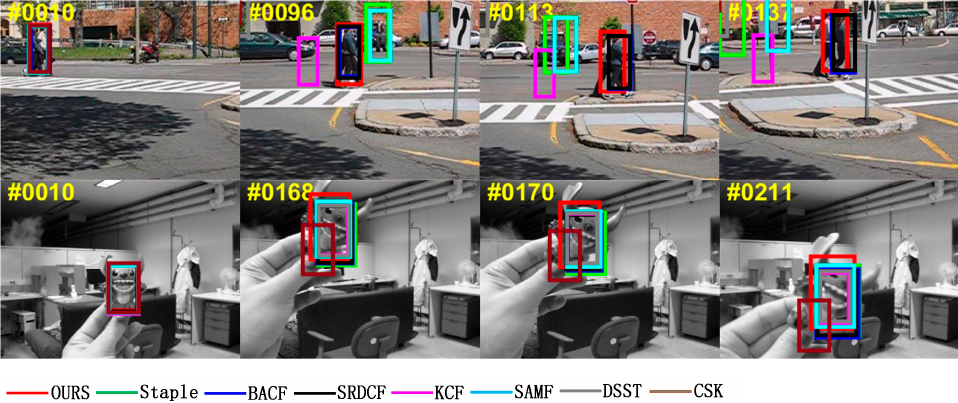
Figure 8. Visual comparison with eight trackers in the “Couple_1” and “Toy_1” video sequences in an occlusion challenge scenario.